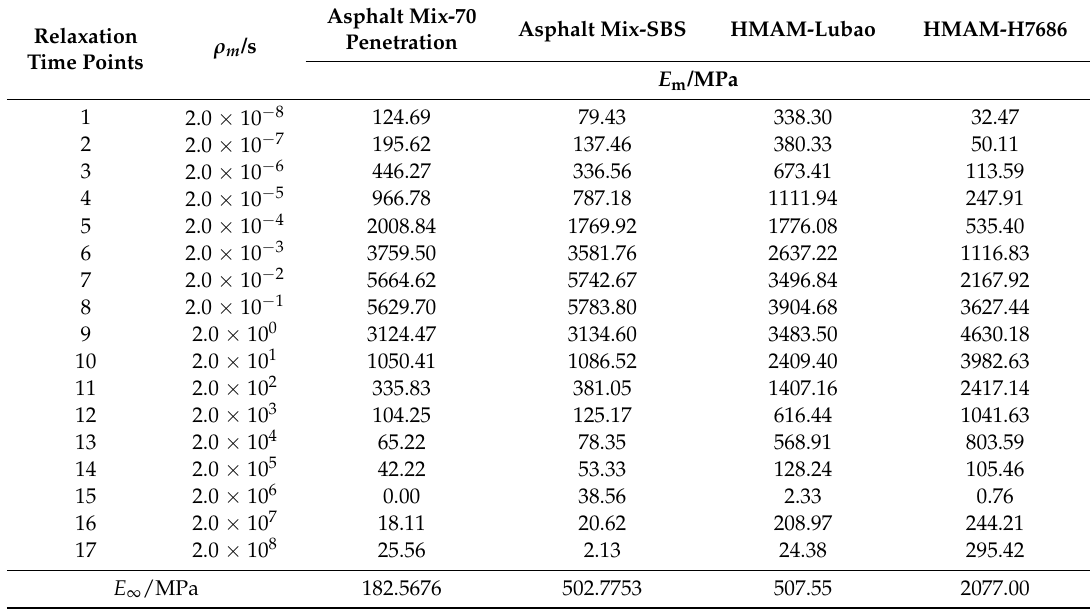
Table 9. Parameters in Prony series representations for relaxation moduli at 20 ◦